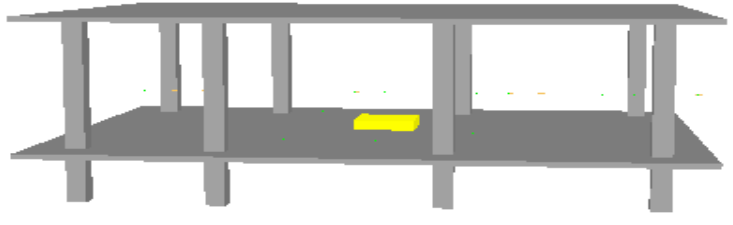
Figure 7. The simplified model in FDS.